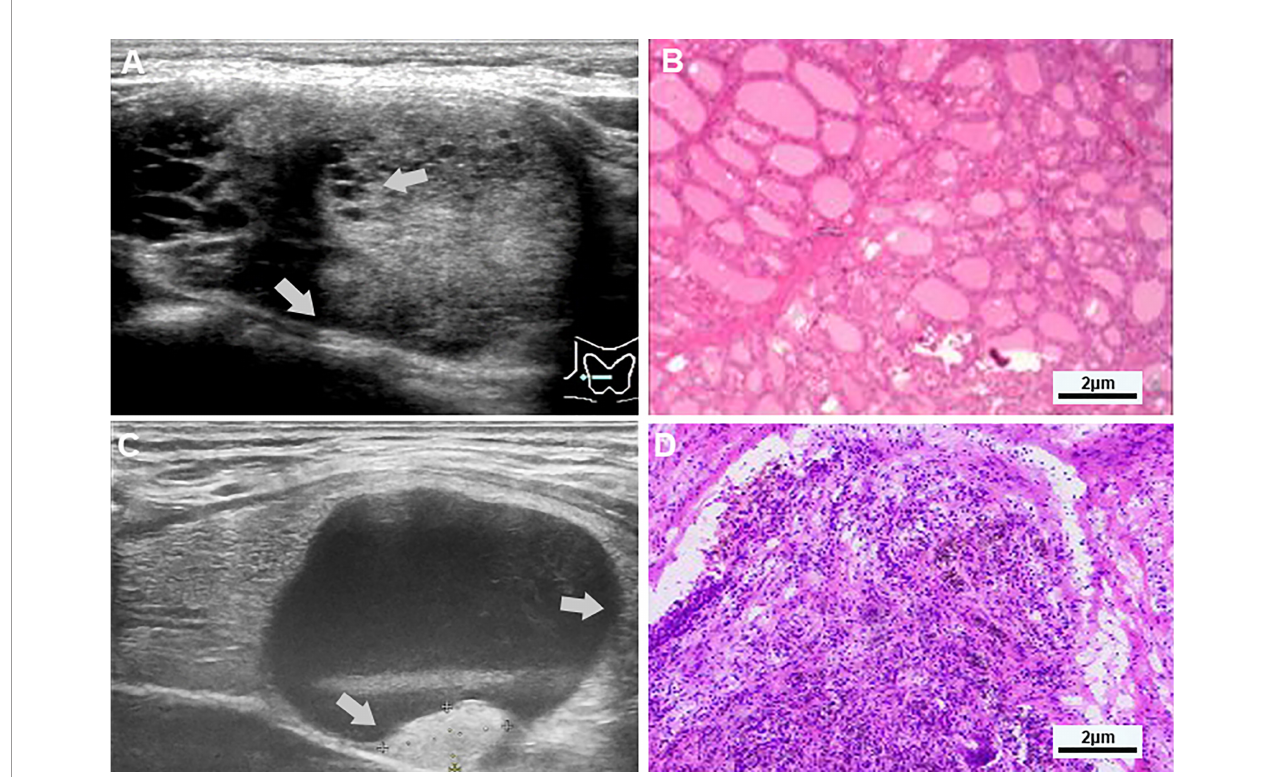
FIGURE 1 | (A, B) Examples of typical ultrasonographic and pathological sections of multiple separation partially cystic thyroid nodules. Transverse section of a cystic-solid nodule of the thyroid, mainly solid, with smooth and irregular margins, and an acute angle between the multiple-separated and fused solid components and the nodule wall (indicated by gray-white arrows), for the hypoechoic, the free edge is non-smooth, and the pathology con fi rmed nodular goiter. (C, D) Examples of typical ultrasonographic and pathological sections of predominant cystic partially cystic thyroid nodules. Longitudinal section of a cystic-solid nodule of the thyroid, mainly cystic, with smooth, oval nodule margins, and an obtuse angle between the solid part attached to the posterior wall and the nodule wall (indicated by the gray-white arrow), For isoechoic, the free edge is smooth, and the pathology con fi rmed nodular goiter with cystic degeneration, close to the thyroid